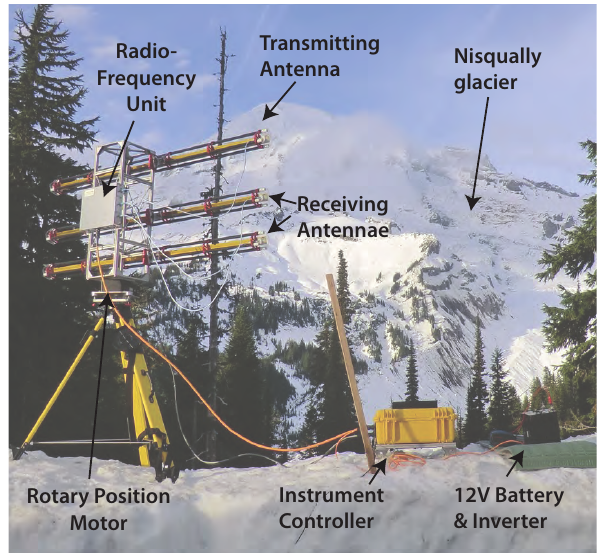
Figure 2. GPRI equipment setup during the 27 November 2012 campaign at ROI